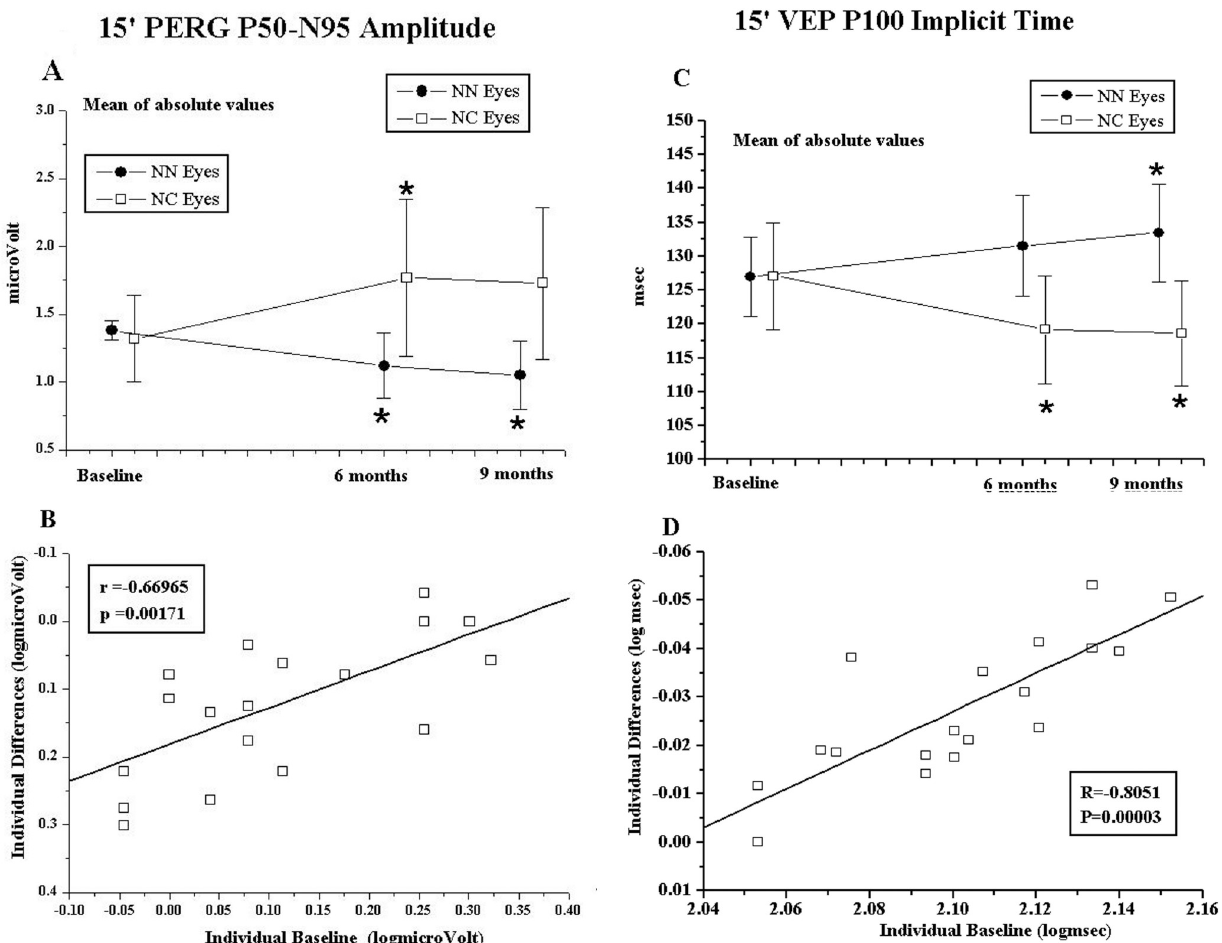
Fig 3. Pattern electroretinogram (PERG) and visual evoked potentials (VEP) P100 implicit time recorded in response to 15’ checks (15’) results. (A) Mean of absolute PERG P50-N95 Amplitude values observed in NC and NN Groups. � = ANOVA, p < 0.01 in NN and NC Groups with respect to baseline. Vertical lines: one mean standard deviation. The statistical evaluation is reported in S2 Table. (B) Individual PERG P50-N95 Amplitude values observed in NC eyes at baseline plotted as a function of the values of the corresponding differences at the end of treatment (6 months minus baseline). Pearson’s test was used for regression analysis and linear correlation. (C) Mean of absolute VEP P100 implicit time values observed in NC and NN Groups. � = ANOVA, p < 0.01 in NN and NC Groups with respect to baseline. Vertical lines: one mean standard deviation. Statistical evaluation is reported in “S2 Table”. (D) Individual VEP P100 implicit time values observed in NC eyes at baseline plotted as a function of the values of the corresponding differences at the end of treatment (6 months minus baseline). Pearson’s test was used for regression analysis and linear correlation.